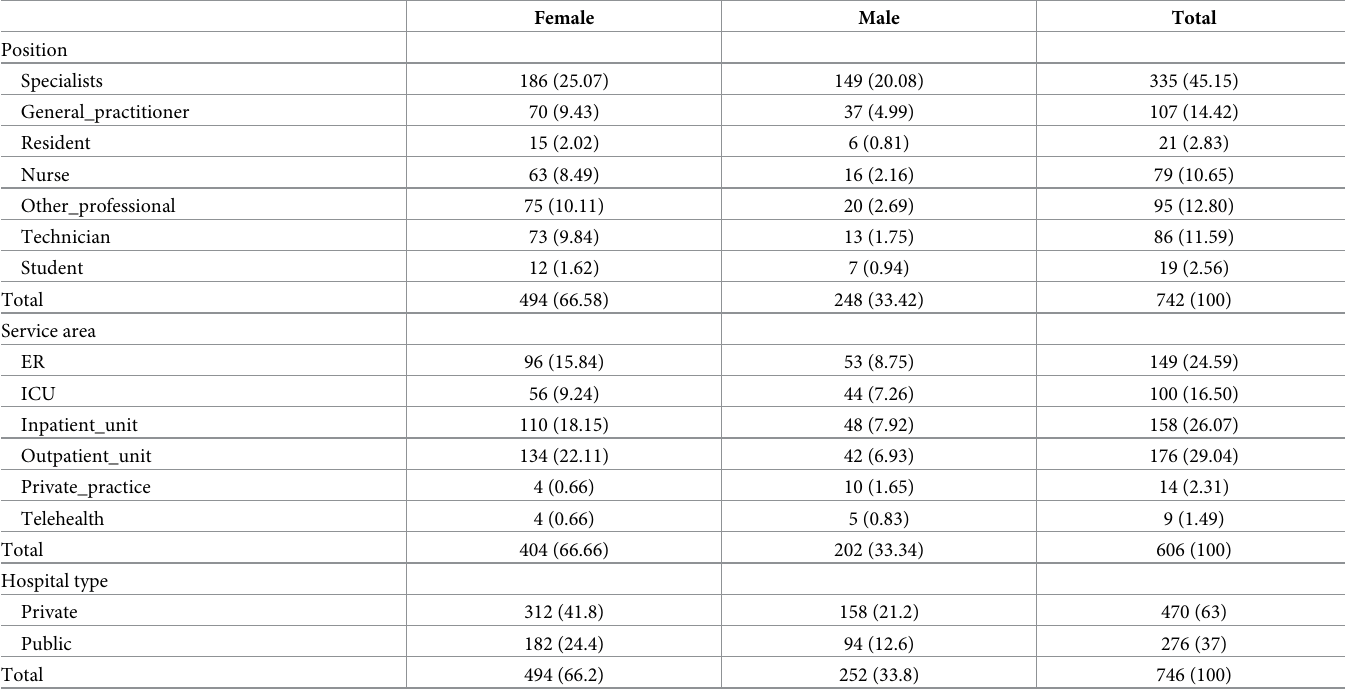
Table 1. Sociodemographic characterization of the